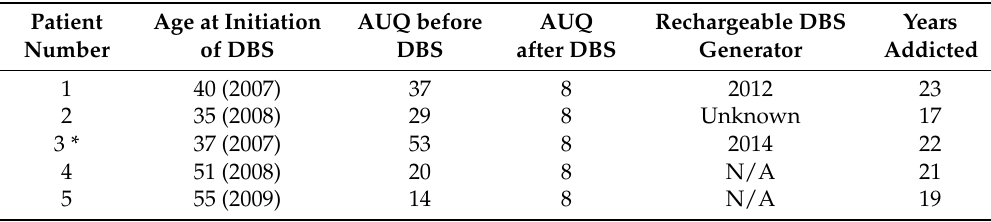
Table 1. Patient Summary from Pilot